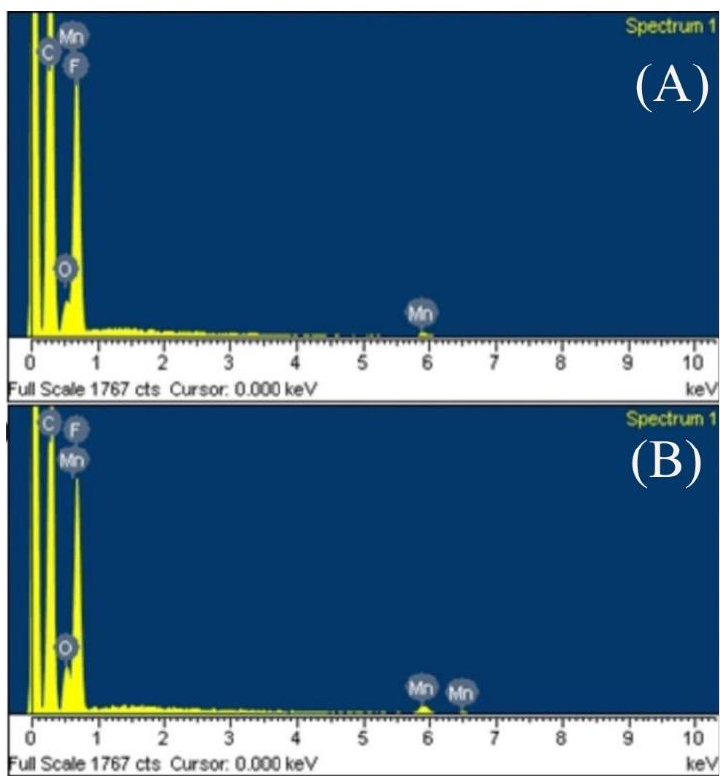
Figure 5. EDS spectrum image of: ( A ) MnO 2 /PTFE HFM; ( B ) Mn 3 O 4 /PTFE HFM. Table 1. The element contents of MnO 2 /Mn 3 O 4 PTFE HFMs. Table 1. The element contents of MnO 2 /Mn 3 O 4 PTFE HFMs.